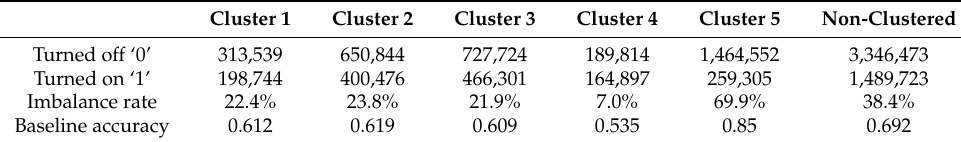
Table 6. The amount, imbalance rate and baseline accuracy of datasets.